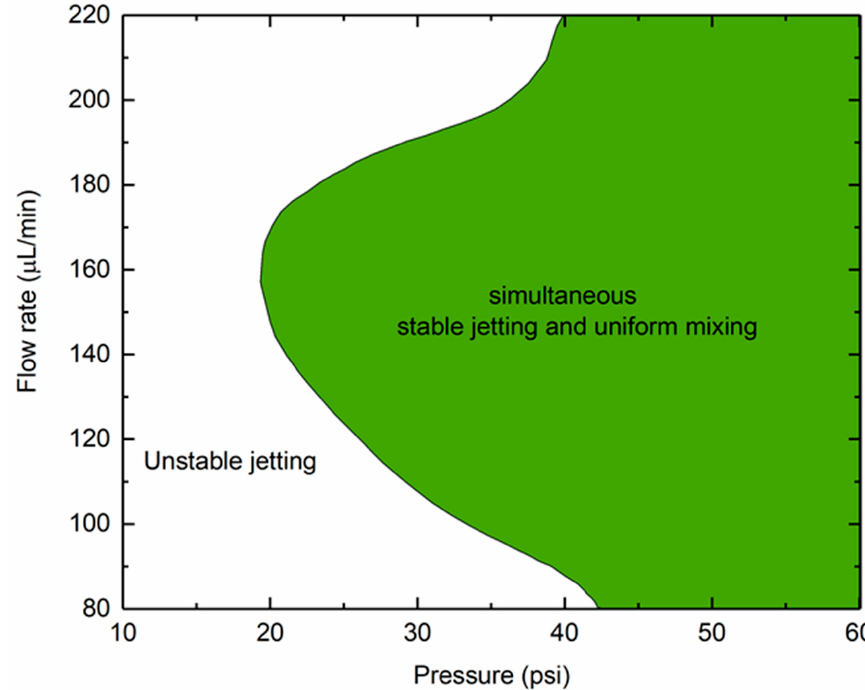
Figure 1. Schematic of the stable operating conditions for our mix-and inject microfluidic devices [40,41] based on optical experiments. Uniform mixing was observed to occur over a flow rate range of 80–220 µL/min. The green area indicates the optimal conditions where both uniform mixing and stable jetting were observed.